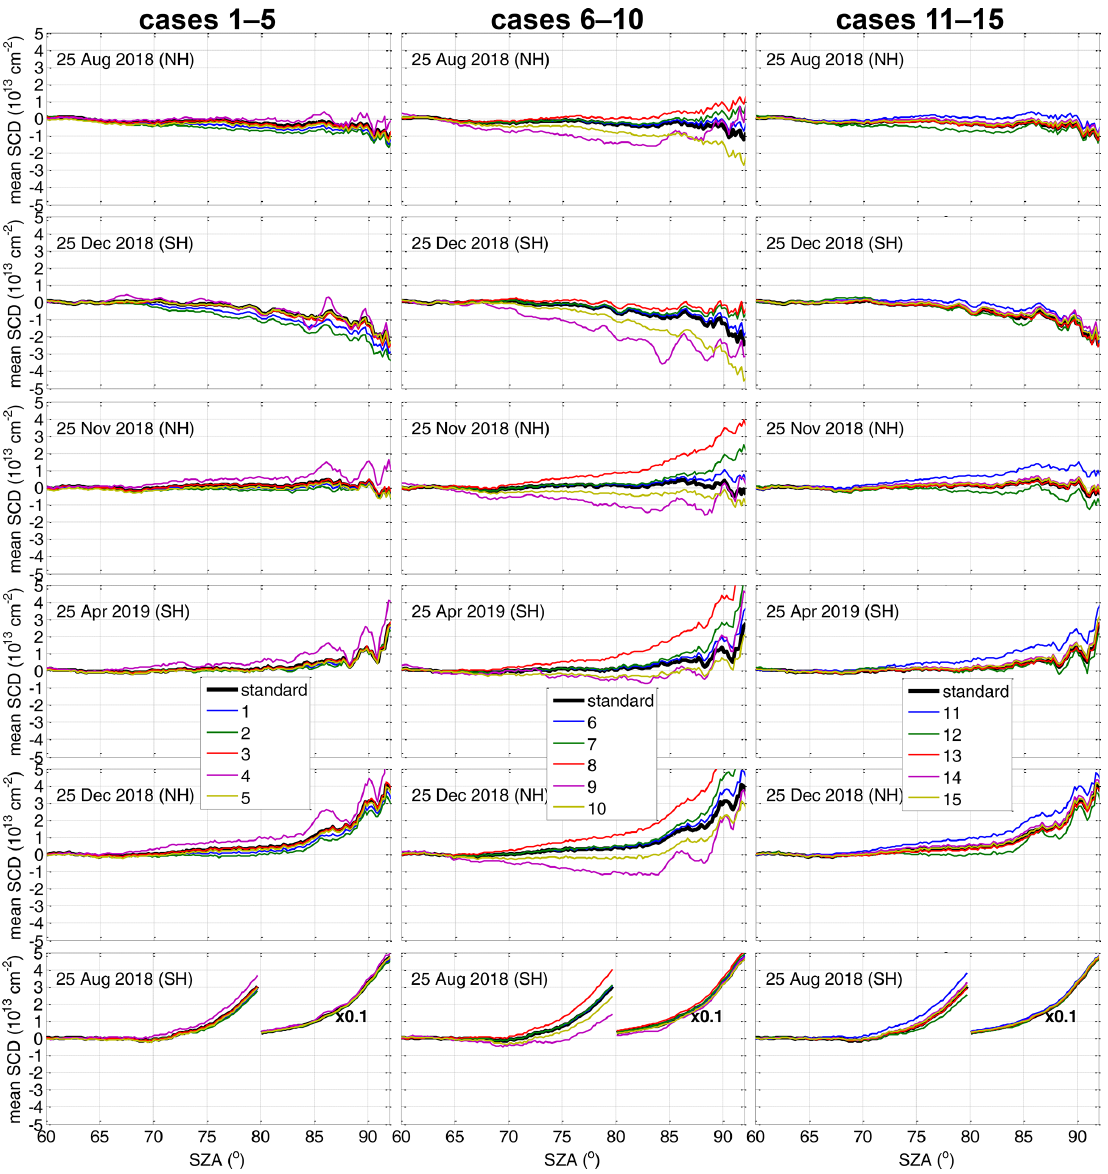
Figure B1. Retrieved daily mean OClO SCDs as a function of SZA (resolution 0.2 ◦ ) for the different cases of the sensitivity study described in Table 2 in comparison to the standard scenario for selected days in both